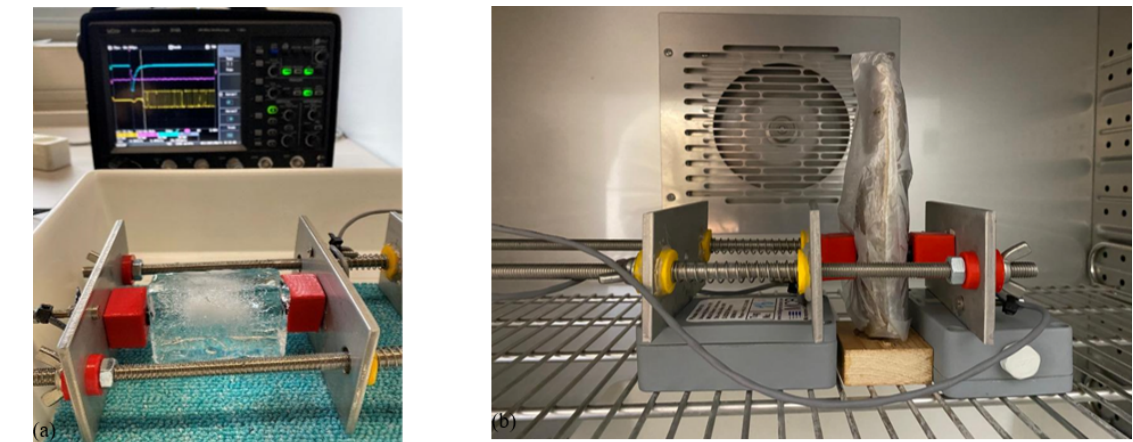
Figure 4. Test setup with an oscilloscope for an ice block (7cm), showing the measurement through the ice block of known length (7cm) to study the change in the speed of sound through the various phases of meltdown. (b) Measuring the change in signal delay through a herring fish in a climate chamber using 200kHz ultrasonic transducers.